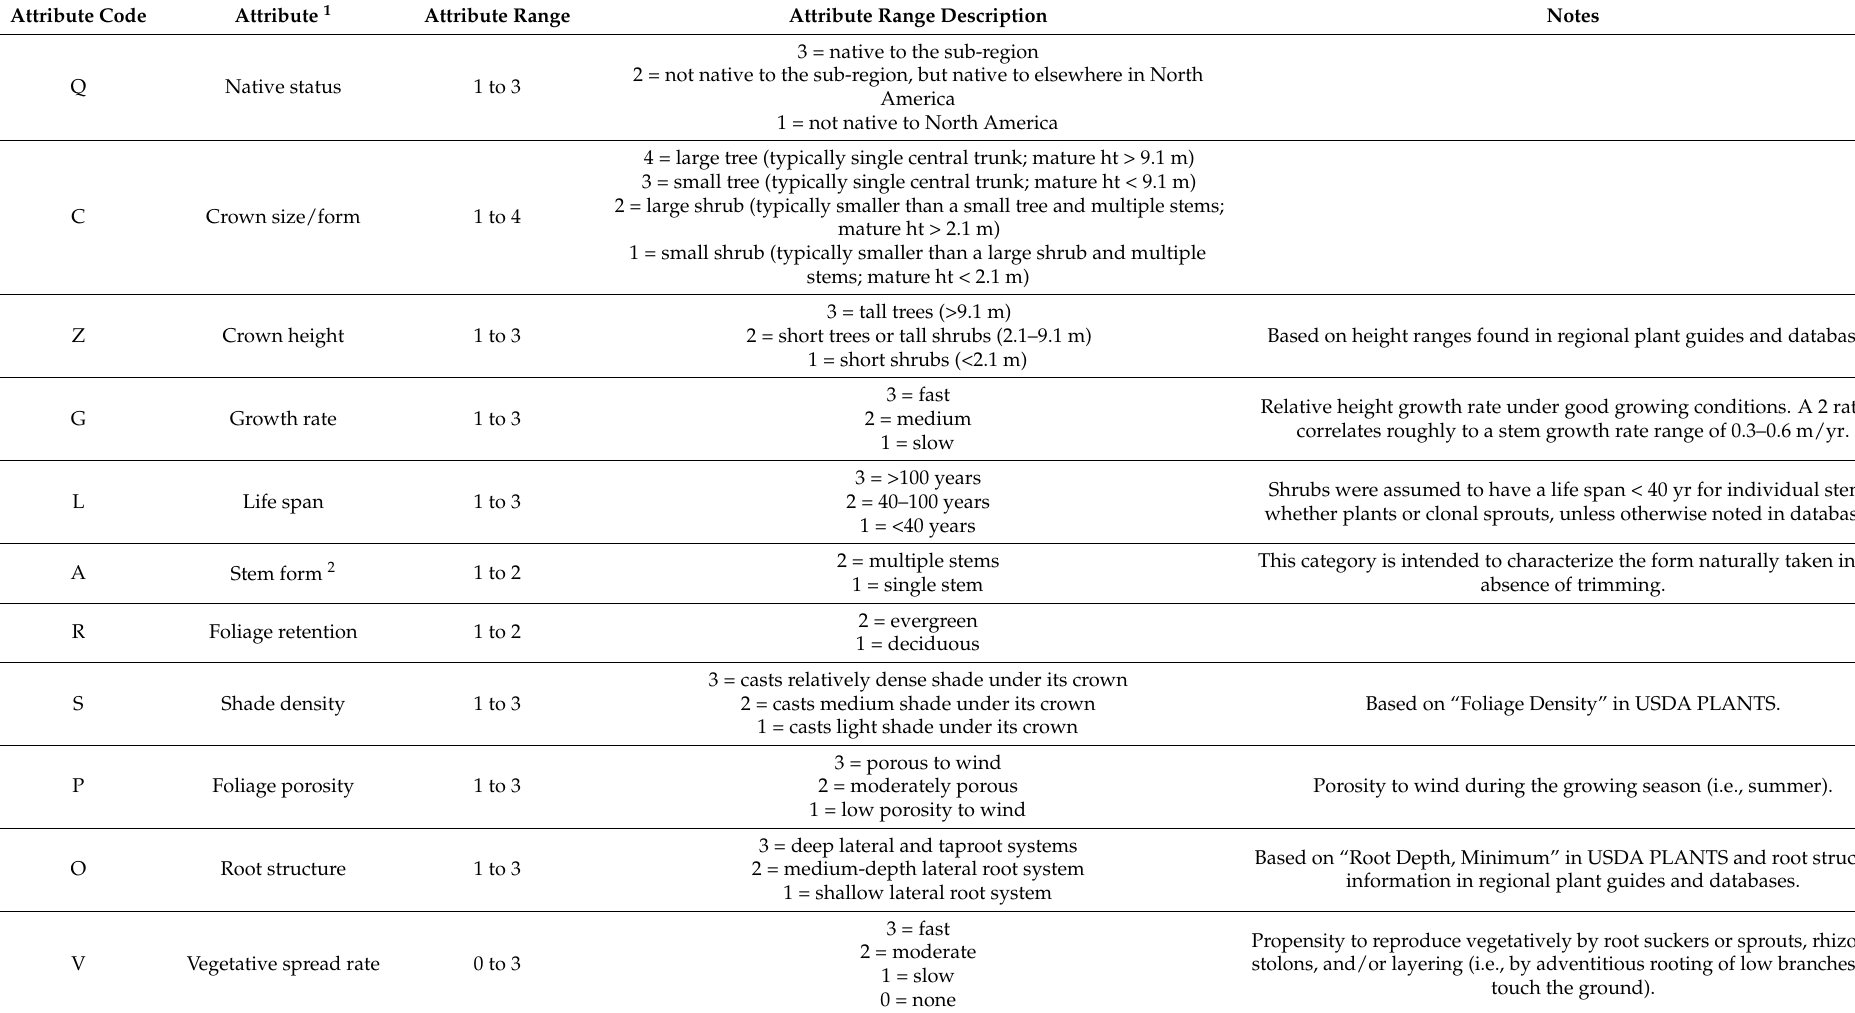
Table 2. Plant attributes used in Tree